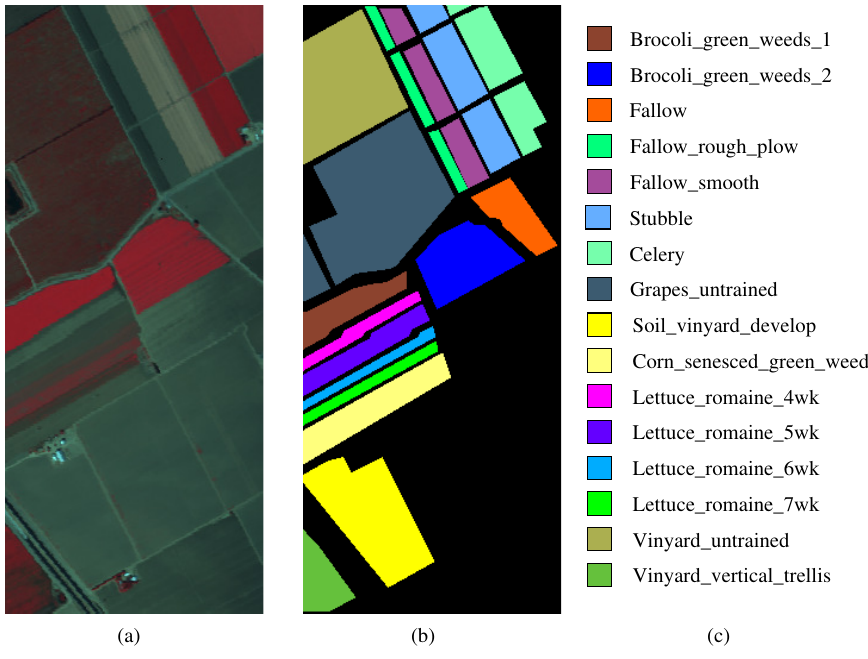
Figure 5. Salinas dataset. ( a ) Three-band color composite of the Salinas image. ( b , c ) Ground truth image and reference